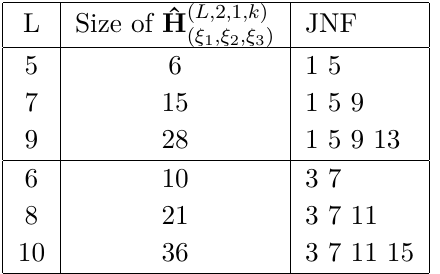
Table 1 . JNF for L , M = 3 , K = 1 (numerical